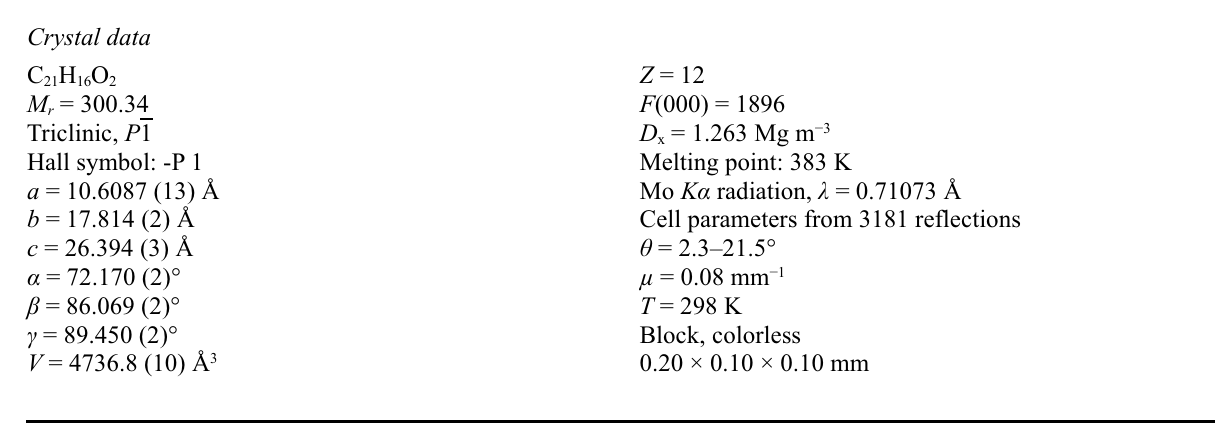
Figure 2 A view of the six independent molecules, only O atoms were labelled and all H atoms have been omitted for clarity.